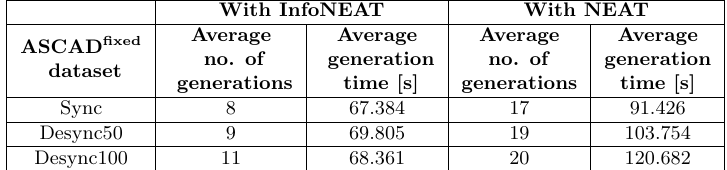
Table 2: Comparison of the time taken for InfoNEAT versus NEAT to train a sub-model for each ASCAD fixed dataset. With InfoNEAT With NEAT Average ASCAD fixed no. of dataset